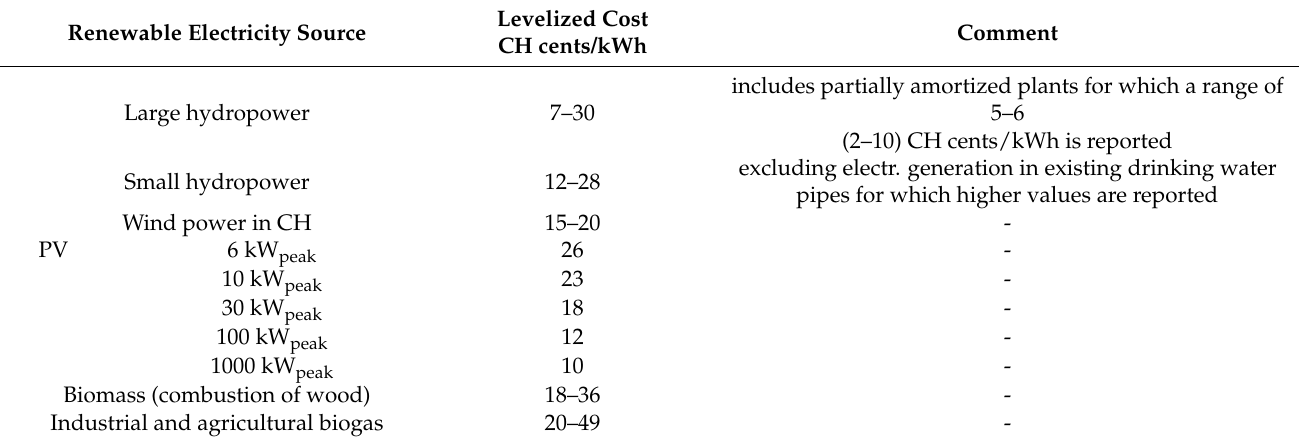
Table 4. Levelised cost of renewable electricity supply in Switzerland